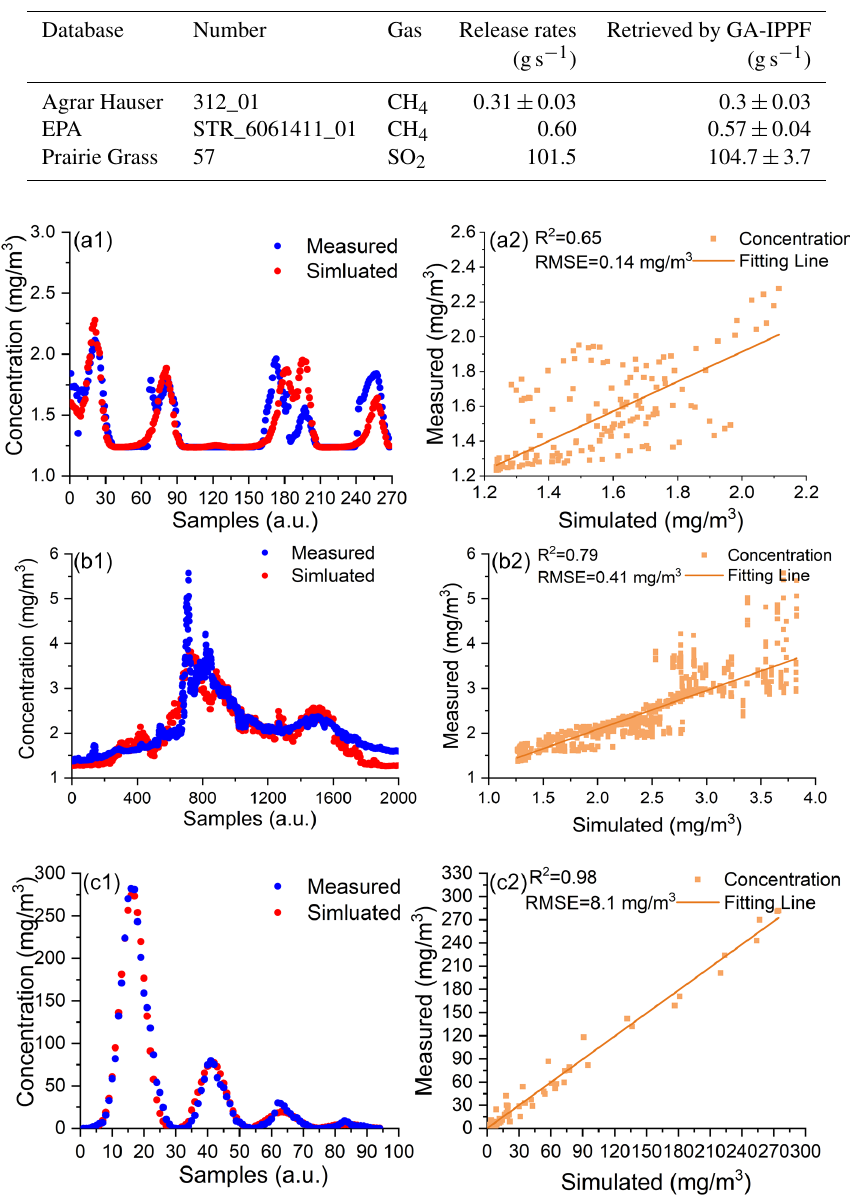
Figure 10. The simulated gas diffusions based on retrieved parameters in control release experiments. Panels (a1) and (a2) are comparisons between simulated diffusion and actual samples in Agrar Hauser. Panels (b1) and (b2) are comparisons between simulated diffusion and actual samples in the EPA control release. Panels (c1) and (c2) are comparisons between simulated diffusion and actual samples in the Prairie Grass